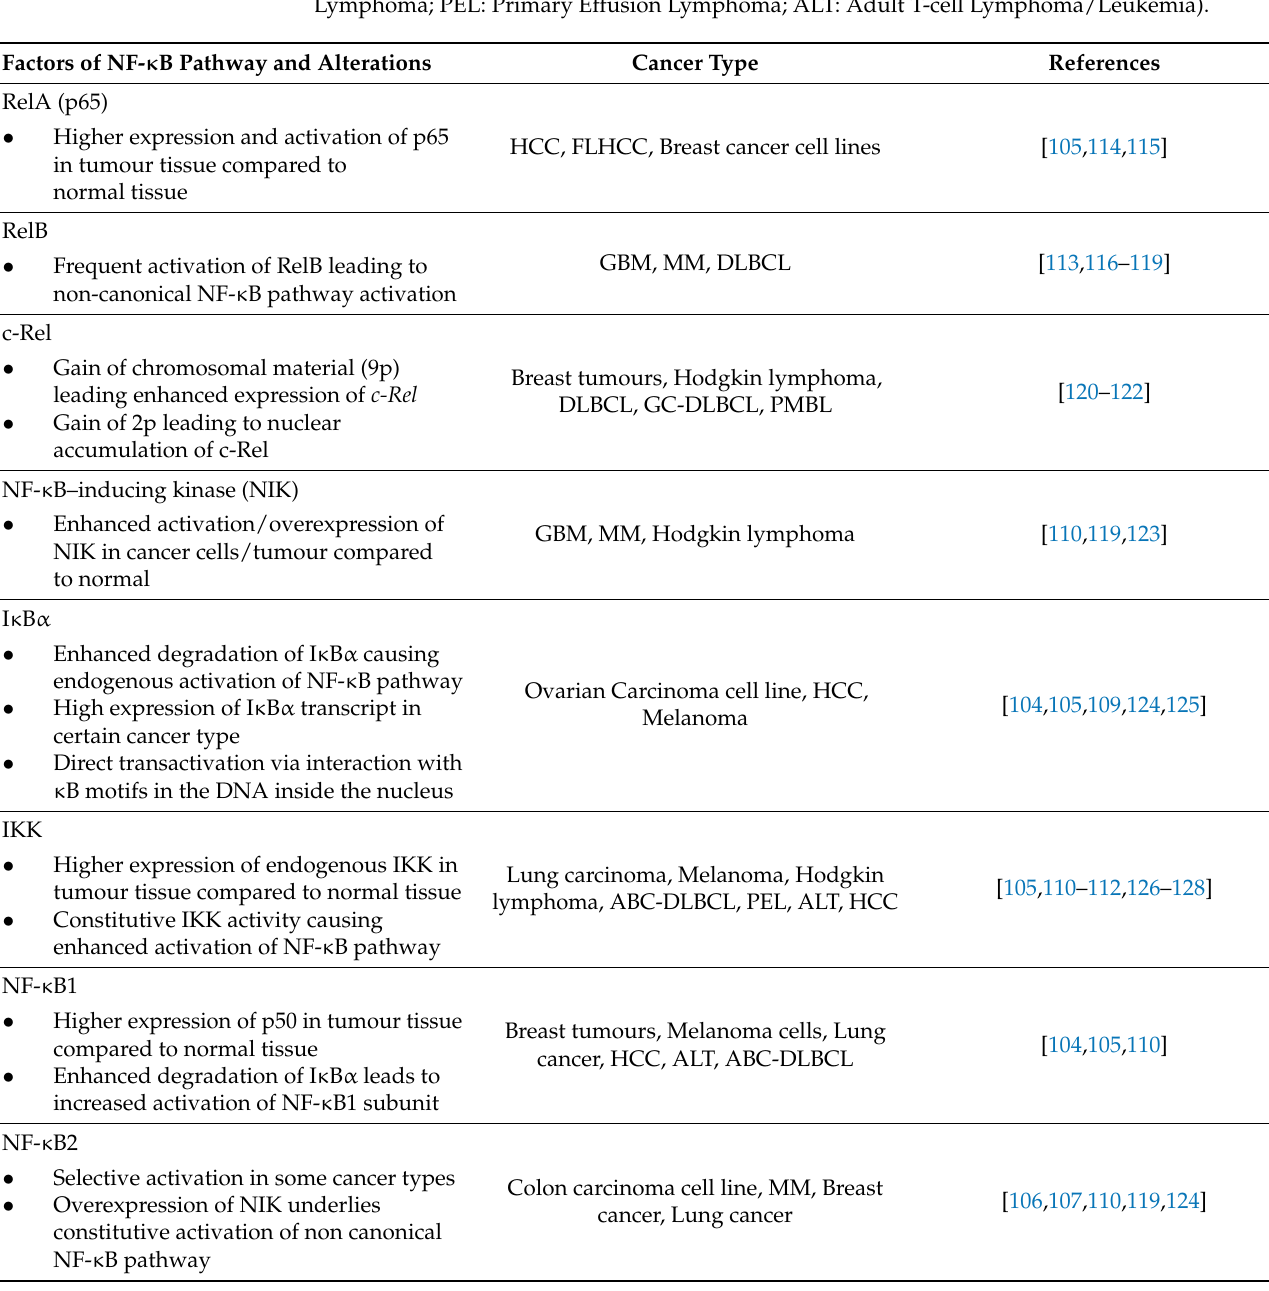
Table 1. Summarized table of alteration of different components of NF- κ B pathway in different cancer types (HCC: Human Colorectal Carcinoma; FLHCC: Fibrolamellar Hepatocellular